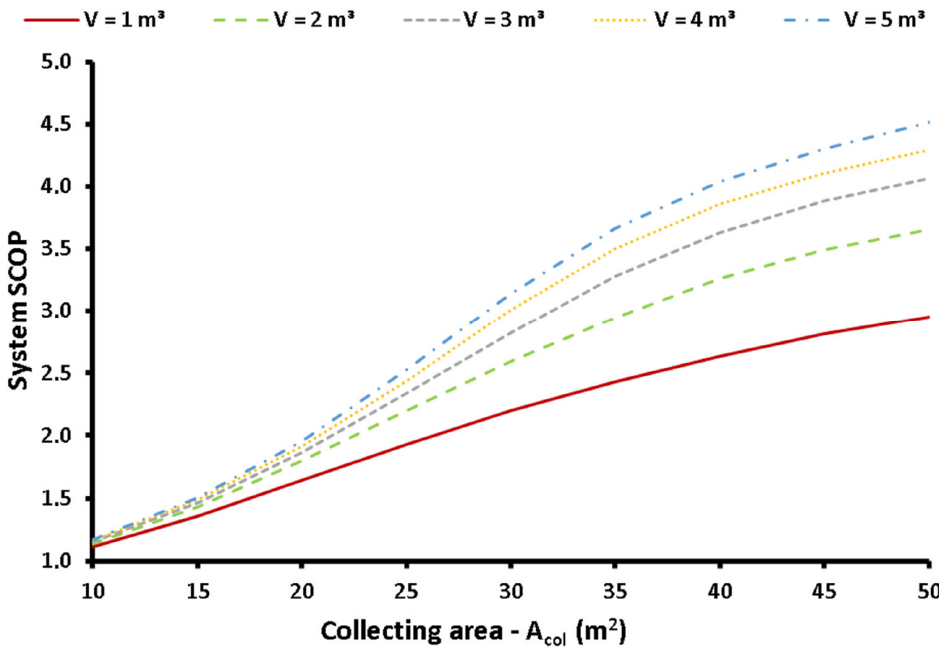
Figure 14. System seasonal COP for different combinations of (A col ) and (V).